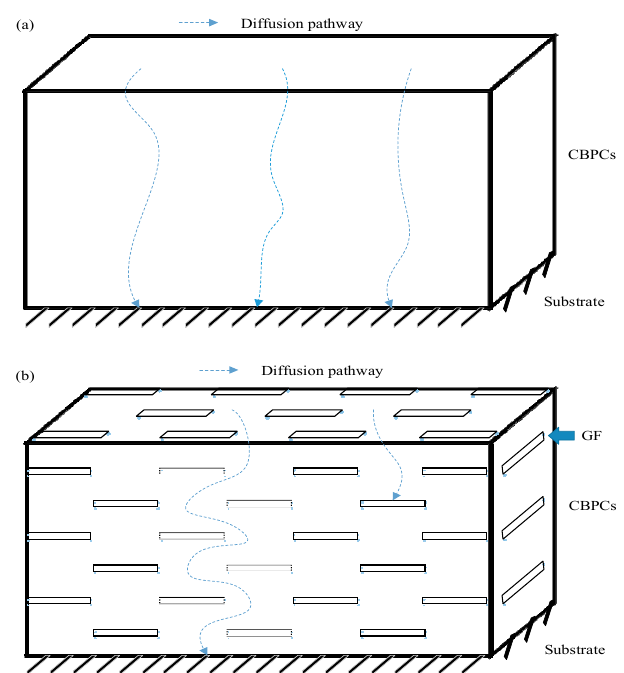
Figure 10. Schematic diagram of the anti-corrosion mechanism in ( a ) CBPCs and ( b ) GCBPCs.